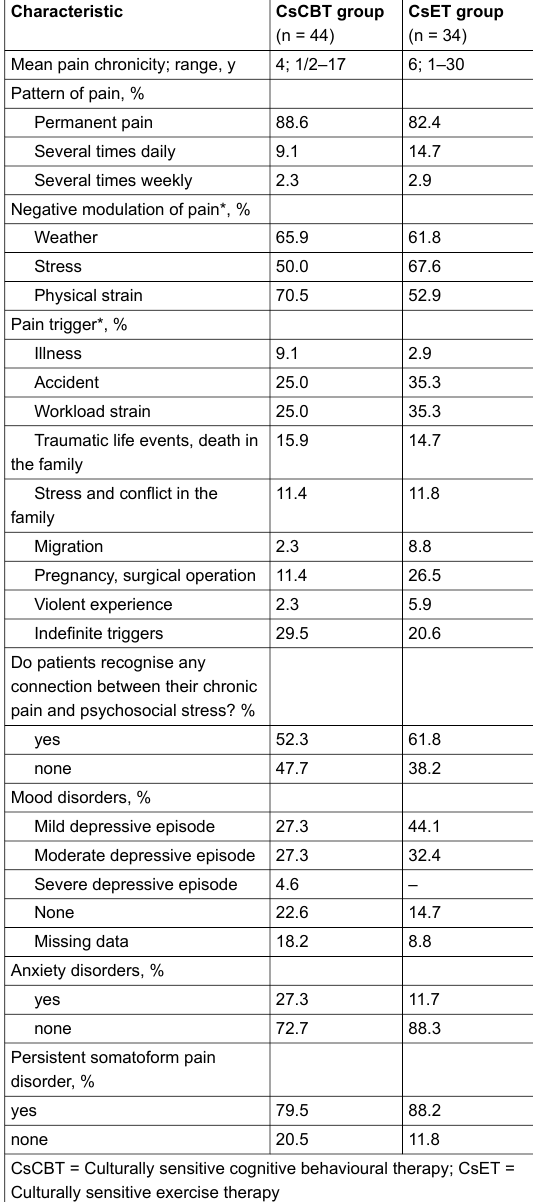
Table 2: Clinical characteristics of group members as collected in the Semistructured Interview.